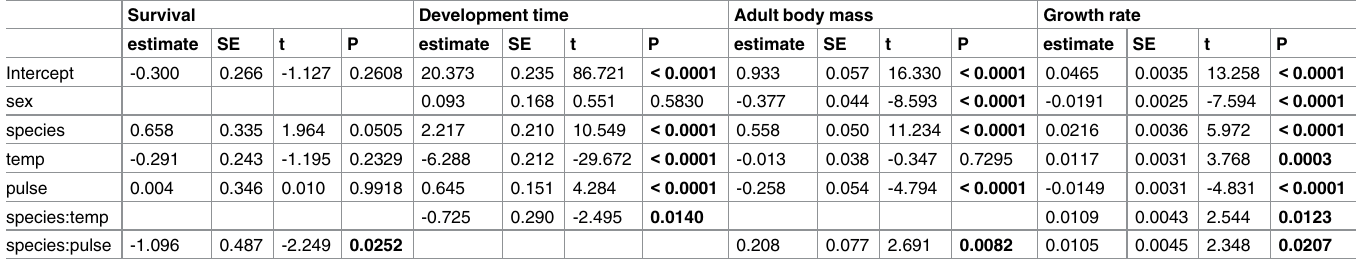
Table 3. Generalized linear model coefficients for life history traits of P . xylostella and D . semiclausum in experiment